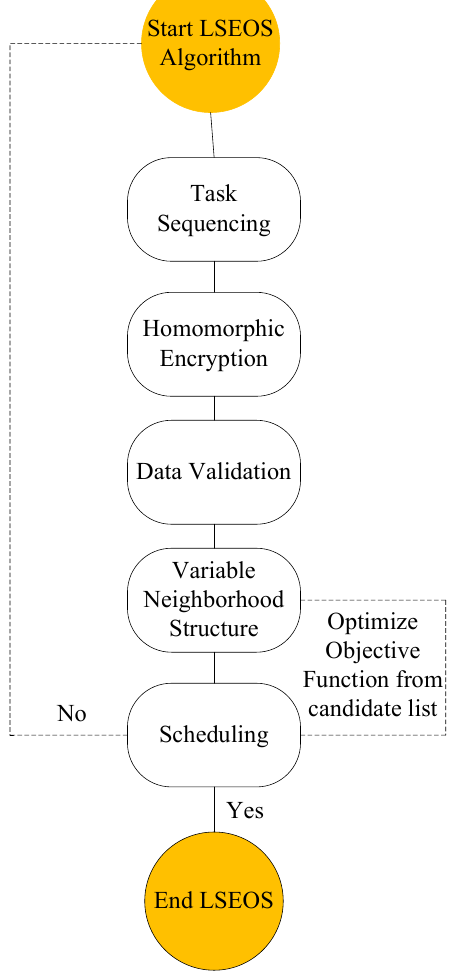
Figure 4. LSEOS metaheuristic algorithm for the considered